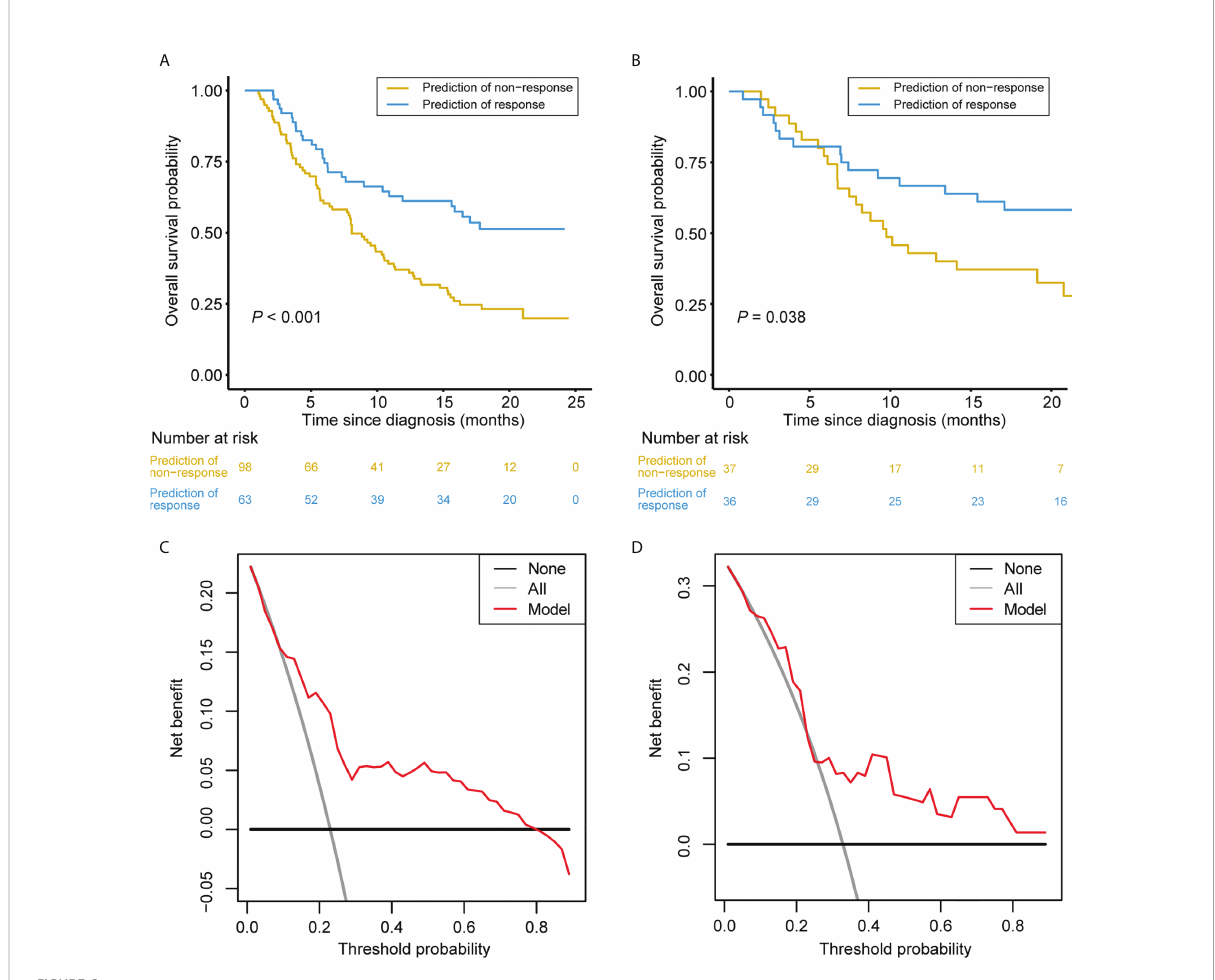
FIGURE 6 Clinical Usefulness of the Nomogram. (A, B) Kaplan-Meier survival curves of patients categorized into response and non-response groups in the training set (A) and validation set (B) , respectively. (C, D) DCA of the nomogram in the training set (A) and validation set (B) , respectively. The x- axis represents the threshold probability. The y-axis measures the net bene fi t. The black line depicts the net bene fi t of the strategy of treating no patients. The gray line depicts the net bene fi t of the strategy of treating all patients. The red line represents the nomogram. The net bene fi t was calculated by subtracting the proportion of all patients who are false positive from the proportion who are true positive, weighting by the relative harm of forgoing treatment compared with the negative consequences of unnecessary treatment. The threshold probability is where the expected bene fi t of treatment is equal to the expected bene fi t of avoiding